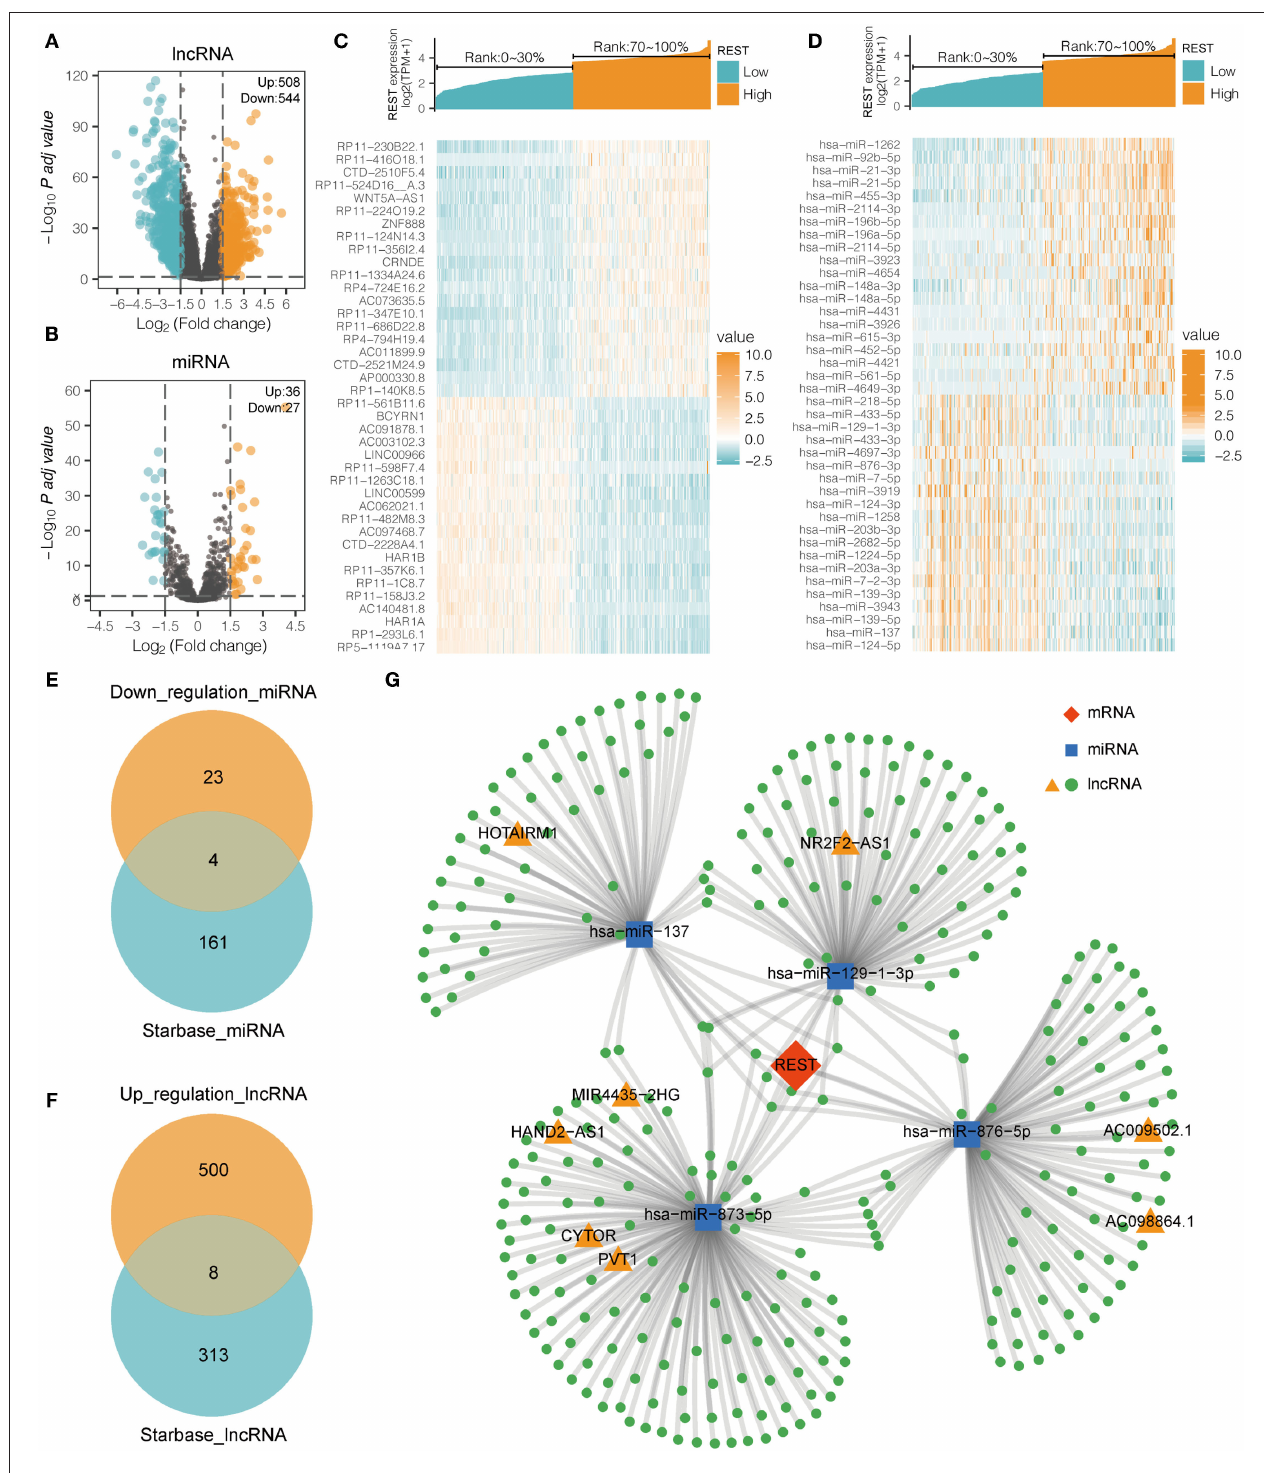
FIGURE 5 | REST ceRNA network construction. (A,B) The volcanic map showing the DE-lncRNA (A) and DE-miRNA (B) of the high (top 30%) and low (bottom 30%) REST expression profiles. (C,D) The heat map showing the top 20 up-regulated and the top 20 down-regulated REST-associated DE-lncRNA (C) and DE-miRNA (D) . (E) Venn diagram illustrating the overlap between miRNAs that are associated with low expression of REST derived from TCGA database and miRNAs which target REST predicted by Starbase. (F) Venn diagram illustrating the overlap between lncRNAs that are associated with over expression of REST derived from TCGA database and the lncRNAs which target the overlap miRNAs predicted by Starbase. (G) LncRNA-miRNA-REST ceRNA network was constructed with predicted miRNAs and lncRNAs.